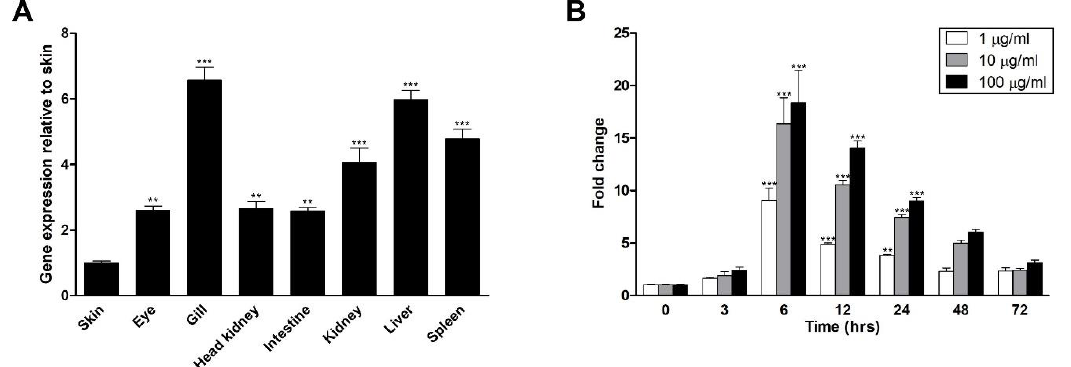
Figure 3. OmA20 expression in fish tissues ( A ) and RTH-149 cells stimulated with LPS ( B ). ( A ) The relative level of OmA20 mRNA expression was evaluated in tissues of rainbow trout using qRT-PCR. Results from qRT-PCR were expressed as a relative fold change compared to skin after normalization against EF1- α. ( B ) RTH-149 cells were stimulated with LPS at different doses (1, 10, and 100 μg /mL), and the expression of OmA20 was measured by qRT-PCR at indicated time points. OmA20 expression level was normalized by the EF1- α level and shown as fold change compared with control cells that had not been stimulated as a value of 1. ** p < 0.01, *** p < 0.001.